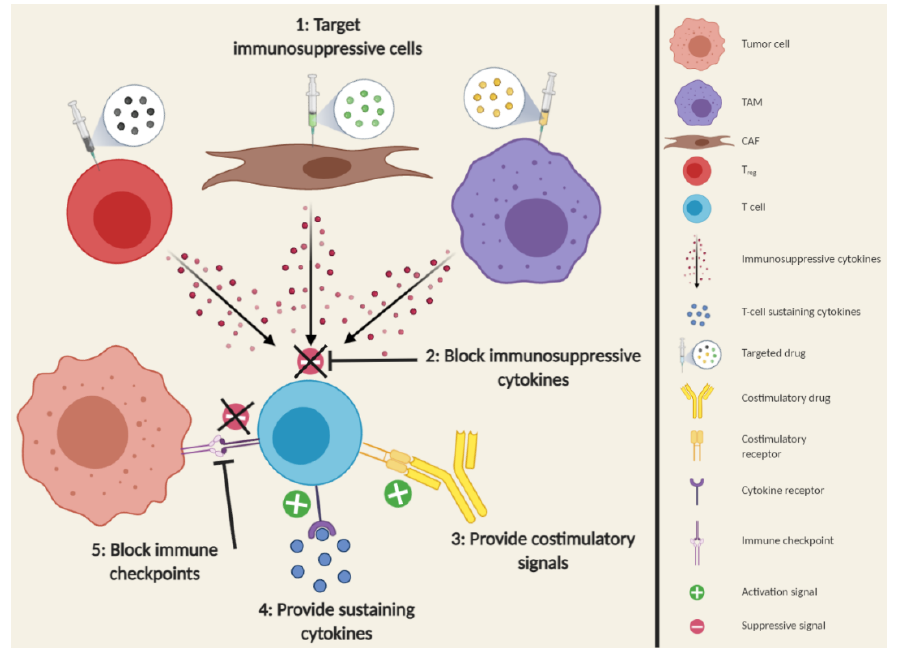
Figure 4. Solutions for hurdle 3: impaired TIL quality. ( 1 ) Targeting immunosuppressive cells such as CAFs, T regs and tumor-associated macrophages (TAMs) depletes producers of immunosuppressive cytokines, thereby decreasing suppressive signals for T cells, improving their effector functions. ( 2 ) Direct blockade of immunosuppressive cytokines, instead of targeting their cellular producers, is able to achieve the same. ( 3 ) Addition of costimulation provides positive signals for T-cell effector functions and survival. ( 4 ) Providing sustaining cytokines can also improve T-cell functioning. ( 5 ) Blockade of immune checkpoints can prevent T-cell dysfunction and allow stronger anti-tumor responses.